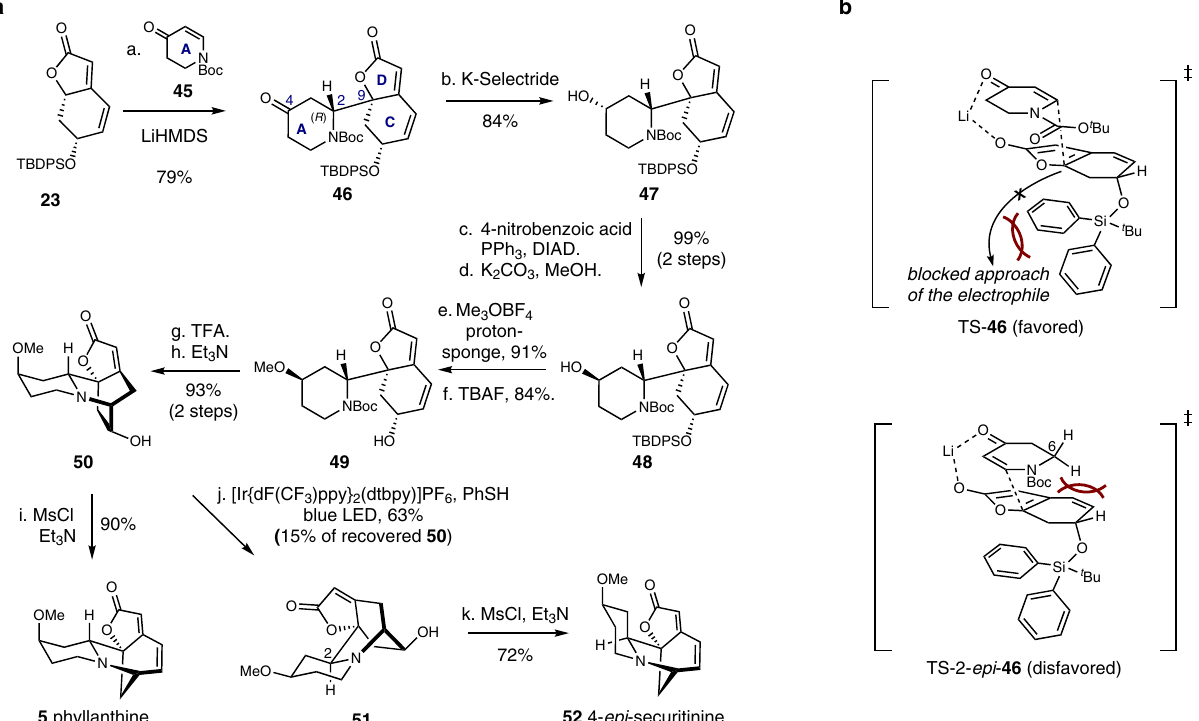
Fig.8|Totalsynthesisofphyllanthine(5)and4-epi-securitinine(52).a Reagents and conditions: (a) 45 (1.5 equiv), LiHMDS (1.2 equiv), THF, – 78°C to – 40°C, 79%; (b) K-selectride (1.2 equiv), THF, – 78°C, 84%; (c) 4-nitrobenzoic acid (2.0 equiv), PPh 3 (1.5equiv),DIAD(2.0equiv),THF, 0°C to23°C;(d)K 2 CO 3 (3.0equiv),MeOH, – 78°C, 99% (2 steps); (e) Me 3 OBF 4 (3.0 equiv), proton-sponge (4.0 equiv), CH 2 Cl 2